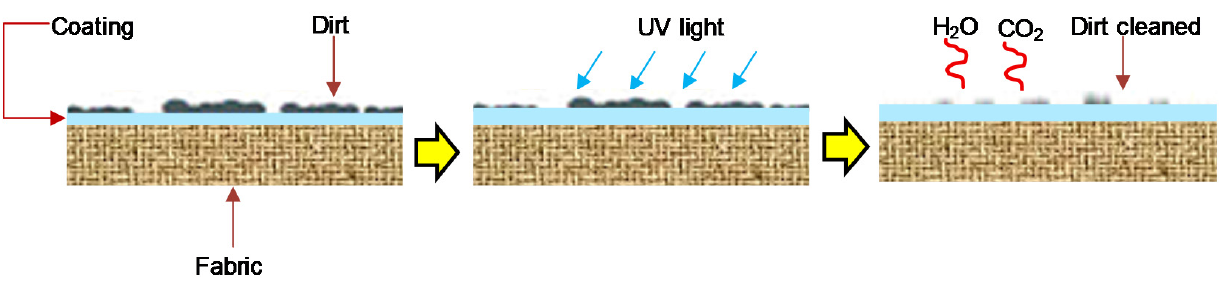
Figure 13. Working principle of self-cleaning fabric.